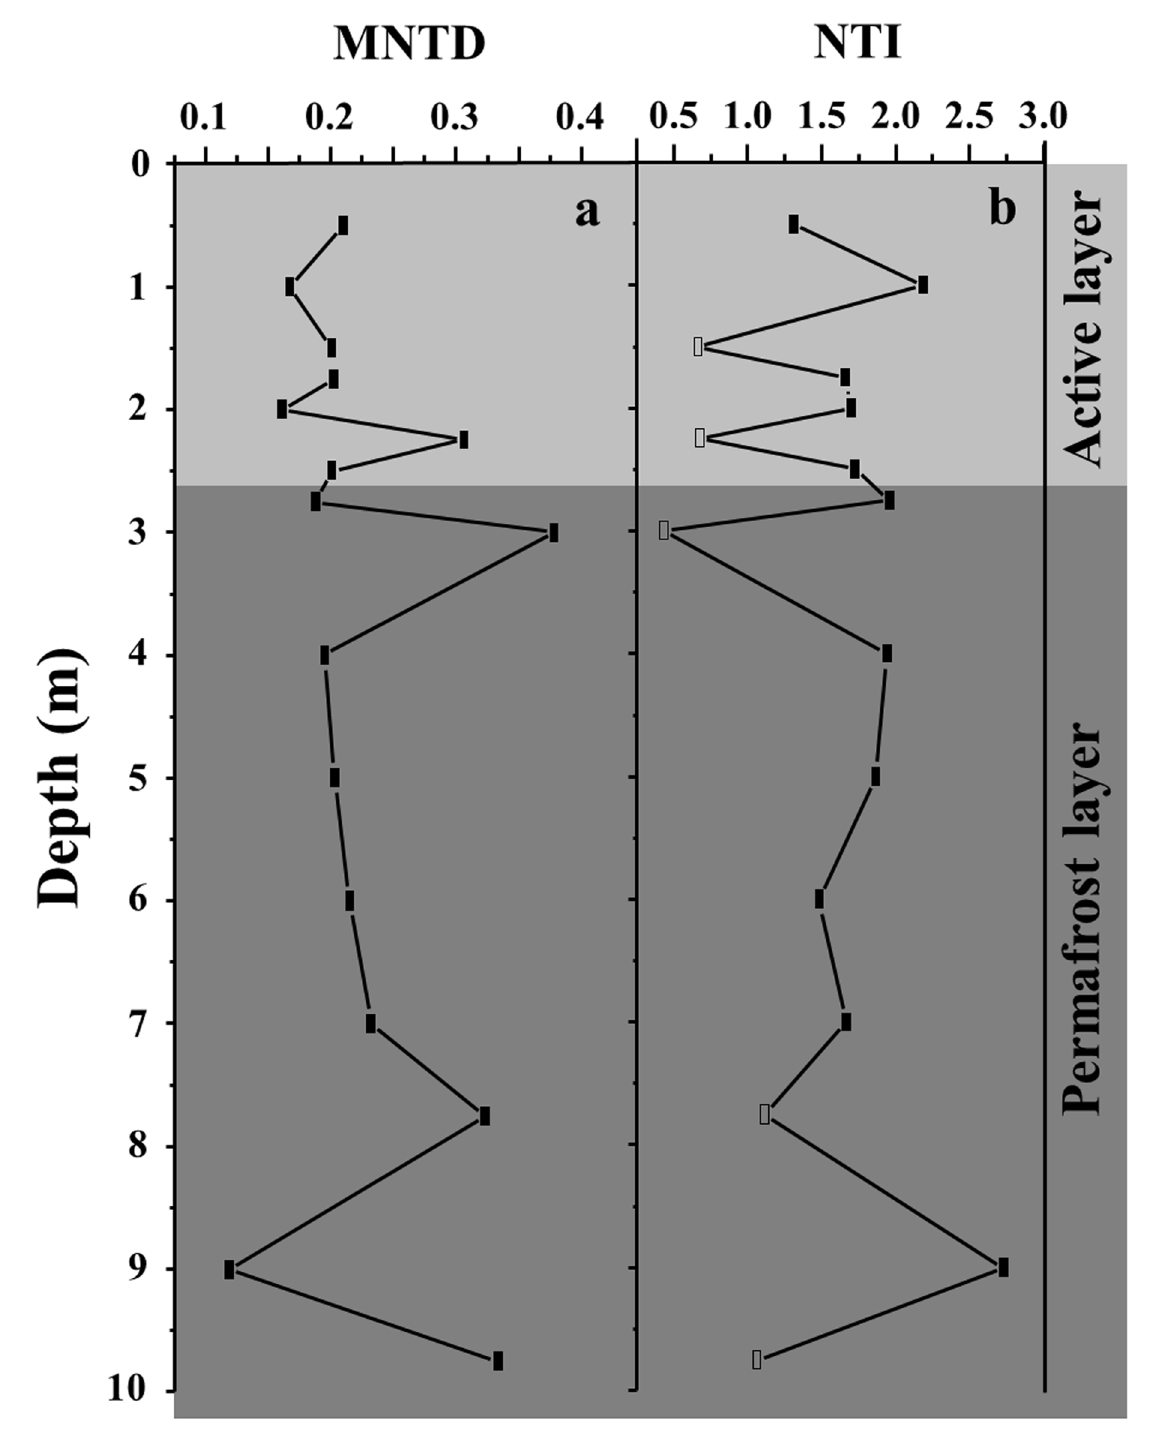
Fig 3. Mean nearest taxon distance (MNTD; a) and nearest taxon index (NTI; b) of different-depth bacterial communities. Observed community phylogenetic structures unlikely to arise by chance ( P < 0.05 or P > 0.95) are depicted by solid symbols (b).